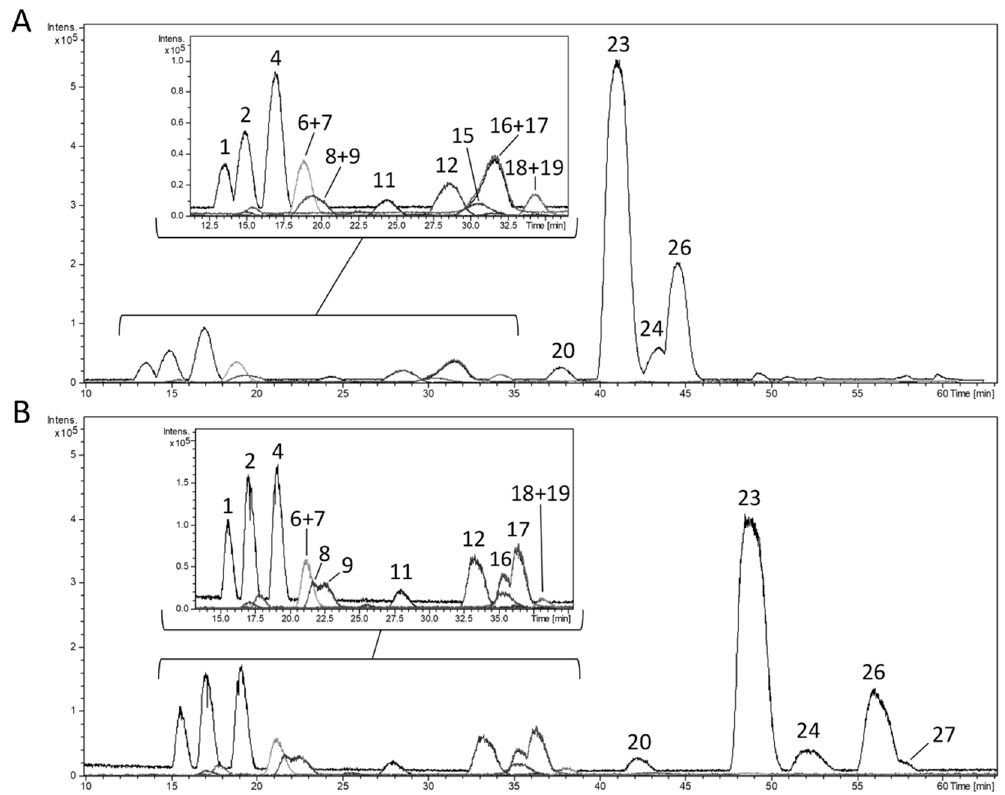
Figure 2. Base peak chromatogram (BPC) of a commercial lemon verbena extract (PLX ® 10) at 50 mg / mL obtained by semi-preparative HPLC-ESI-TOF-MS in negative ion mode applying ( A ) the initial multi-step lineal gradient from the analytical HPLC method, and ( B ) the final multi-step lineal gradient after optimization. Peak numbers correspond to those of Table 1. Table 2. Collected fractions from a commercial lemon verbena extract (PLX ® 10) by semi-preparative chromatography, indicating the major compound(s) identified by HPLC-ESI-TOF-MS, the dry weight of the residue of each fraction and the relative amount taking account the injected quantity. Bold numbers correspond to the peaks with the highest intensity in each isolated